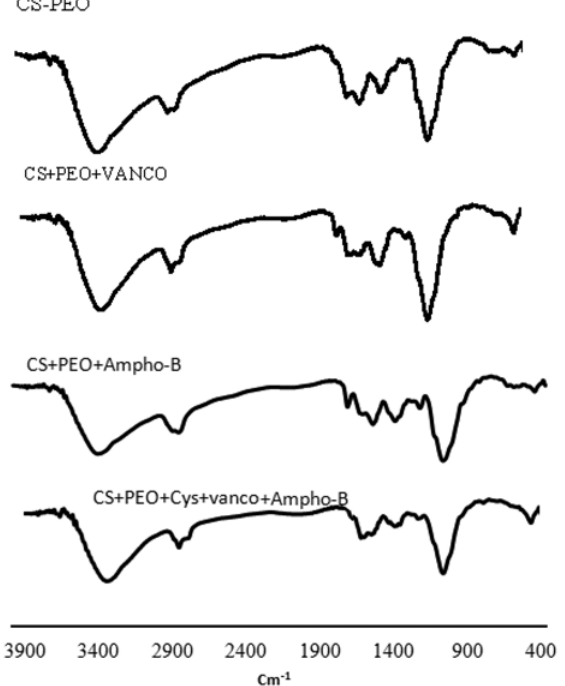
FIGURE 3 - FTIR spectra for CS/PEO, CS/PEO/Cys, CS/PEO/ Drugs, CS/ PEO/Cys/